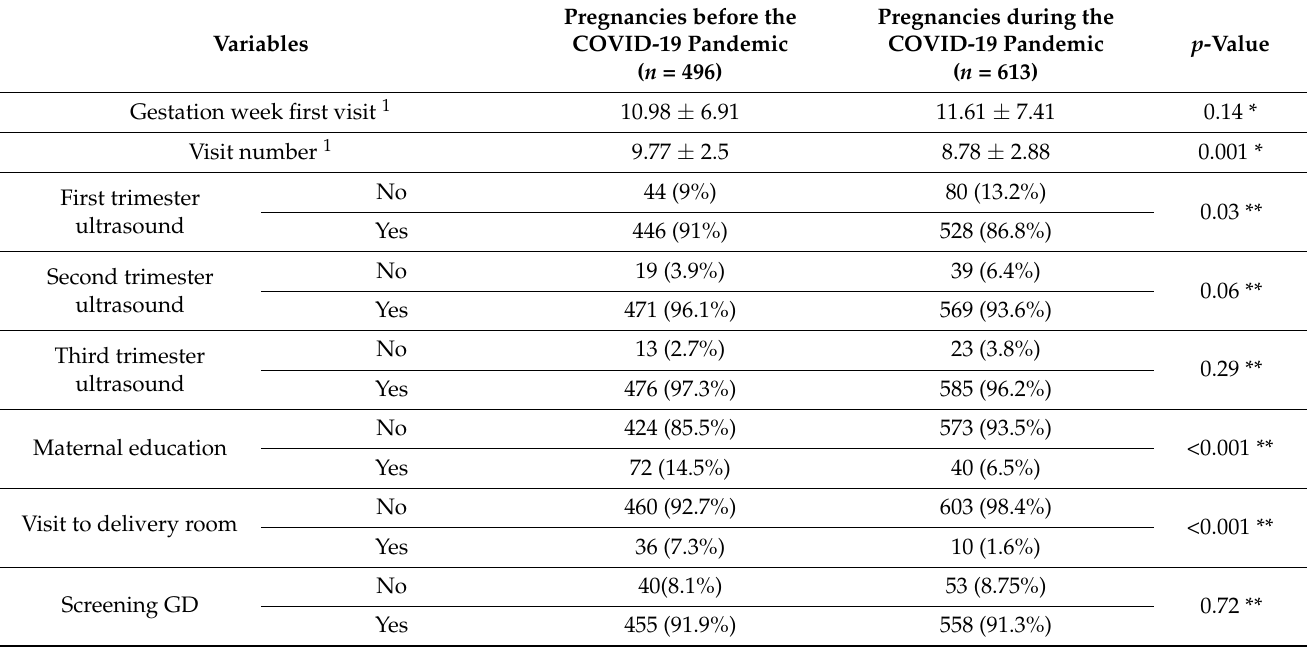
Table 1. Comparison of pregnancy control data between the two groups, “before the COVID-19 pandemic” and “during the COVID-19